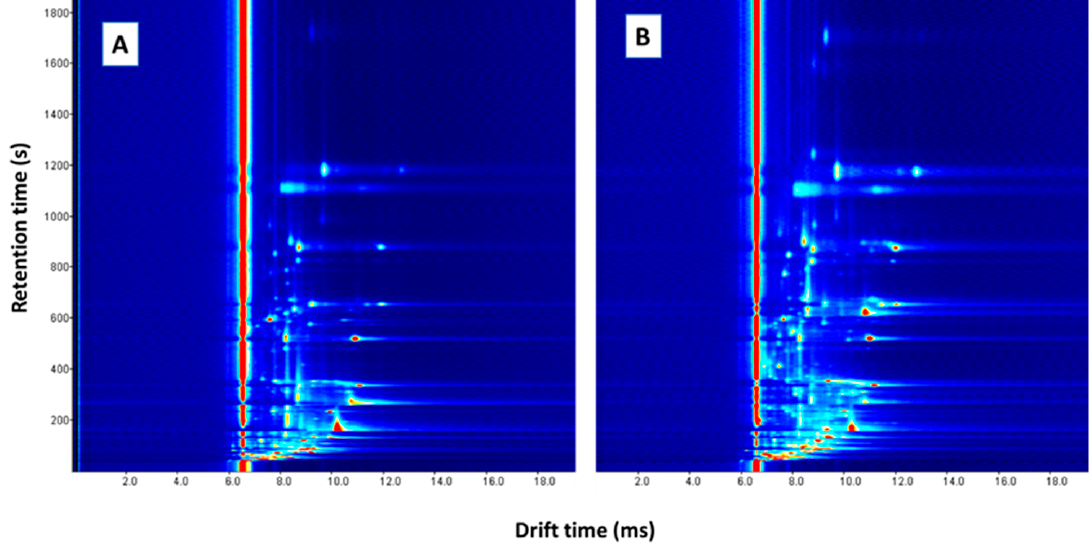
Figure 2. GC-IMS spectra from a sample sampled with: the homogenized fat ( A ); and with a needle ( B ).